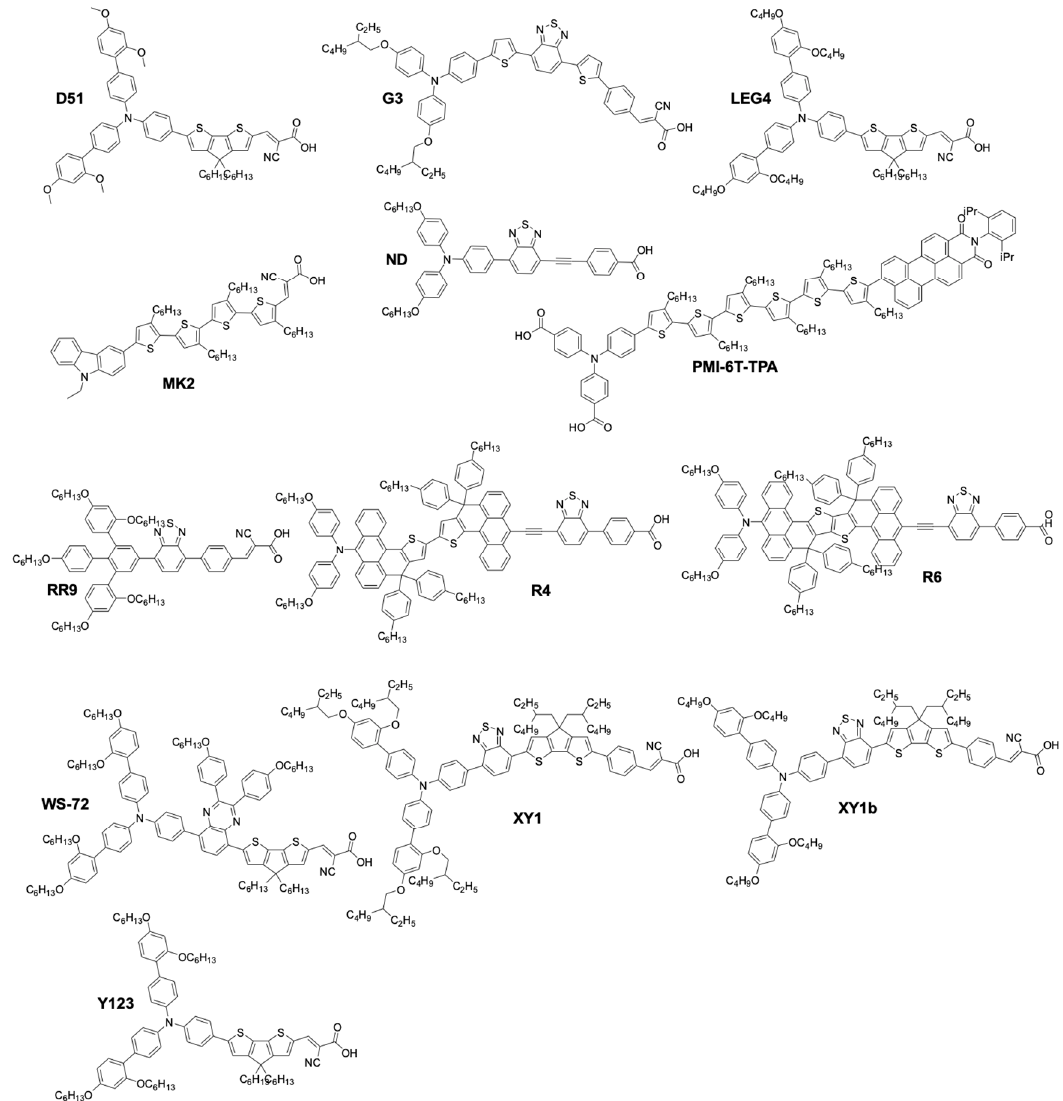
Figure 6. Chemical structure of organic dyes used in DSSCs.